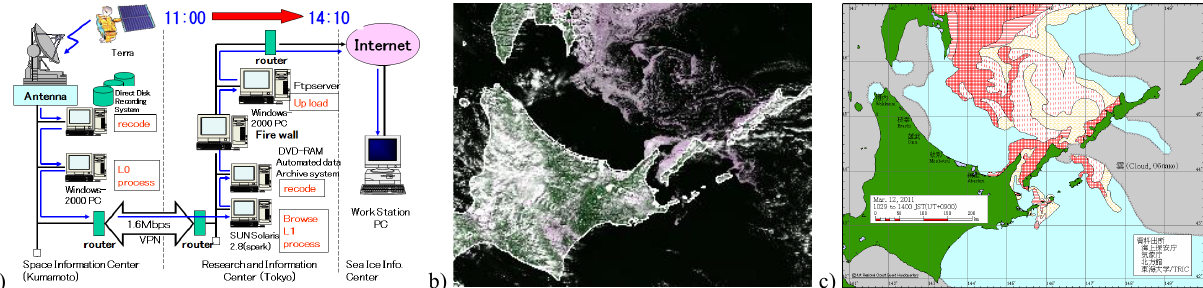
Figure 2. Configuration diagram of near-real-time MODIS data distribution system for sea ice monitoring (a). MODIS image (b) and sea ice chart produced from MODIS images (c).